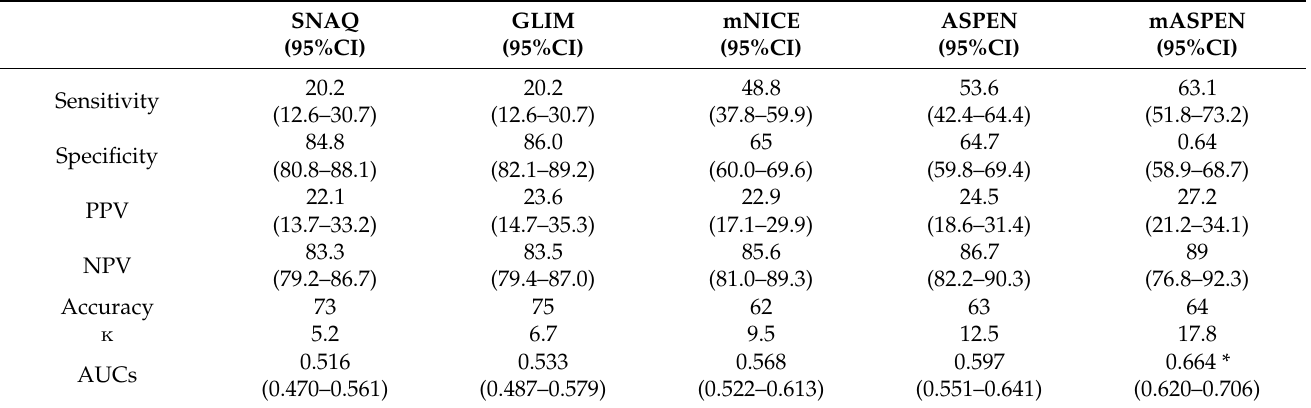
Table 2. The efficiency of the screening tools in identifying RFS.